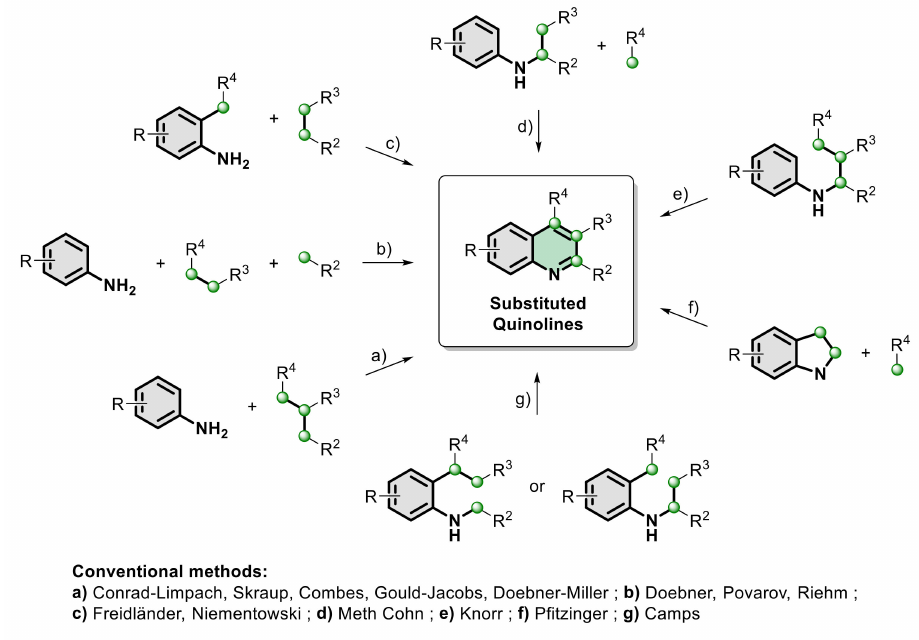
Scheme 1. Main strategies to access quinoline derivatives through conventional